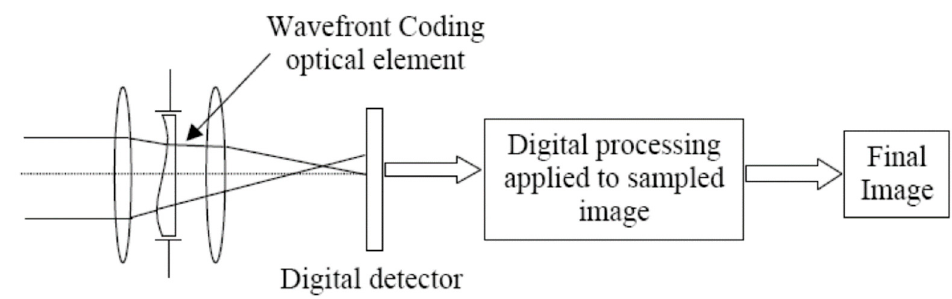
Figure 1. Scheme of wavefront coding technology.